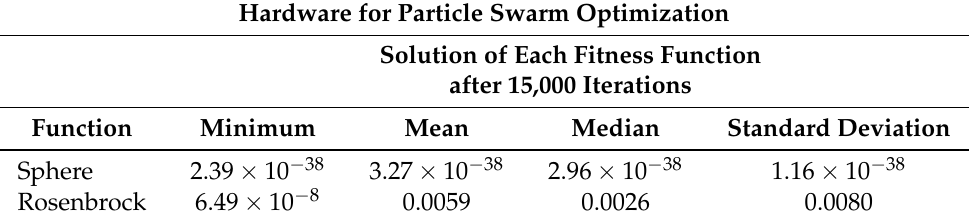
Table 8. Convergence results in the PSO